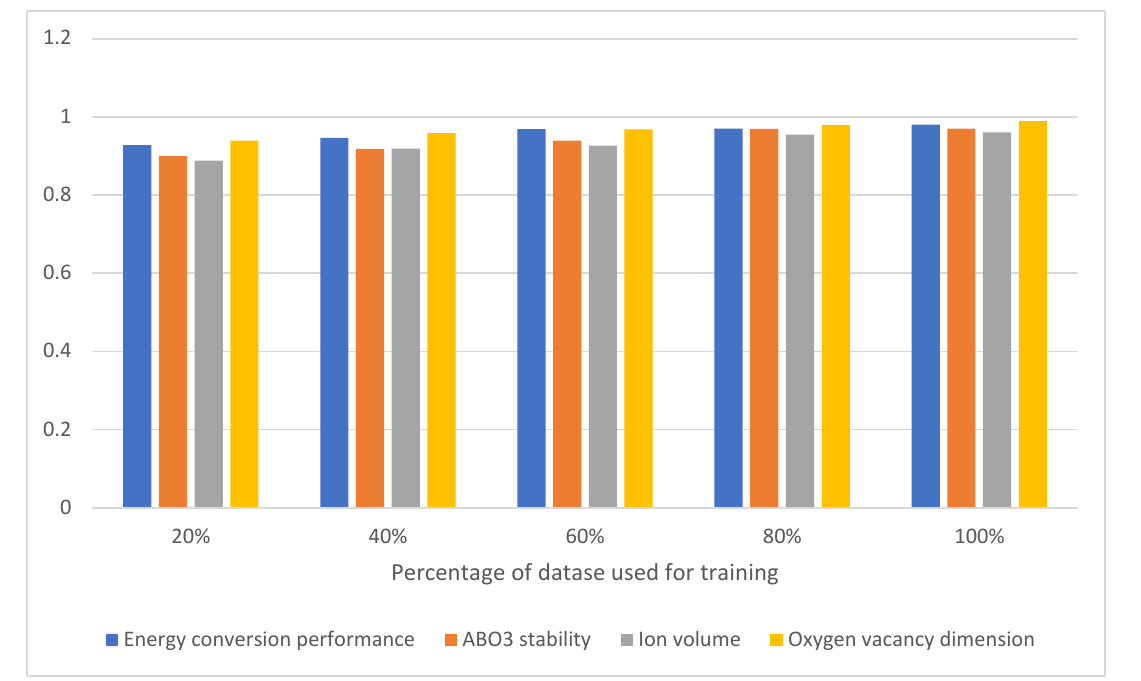
Figure 6. Comparison of the precision of prediction of features versus size of training data.